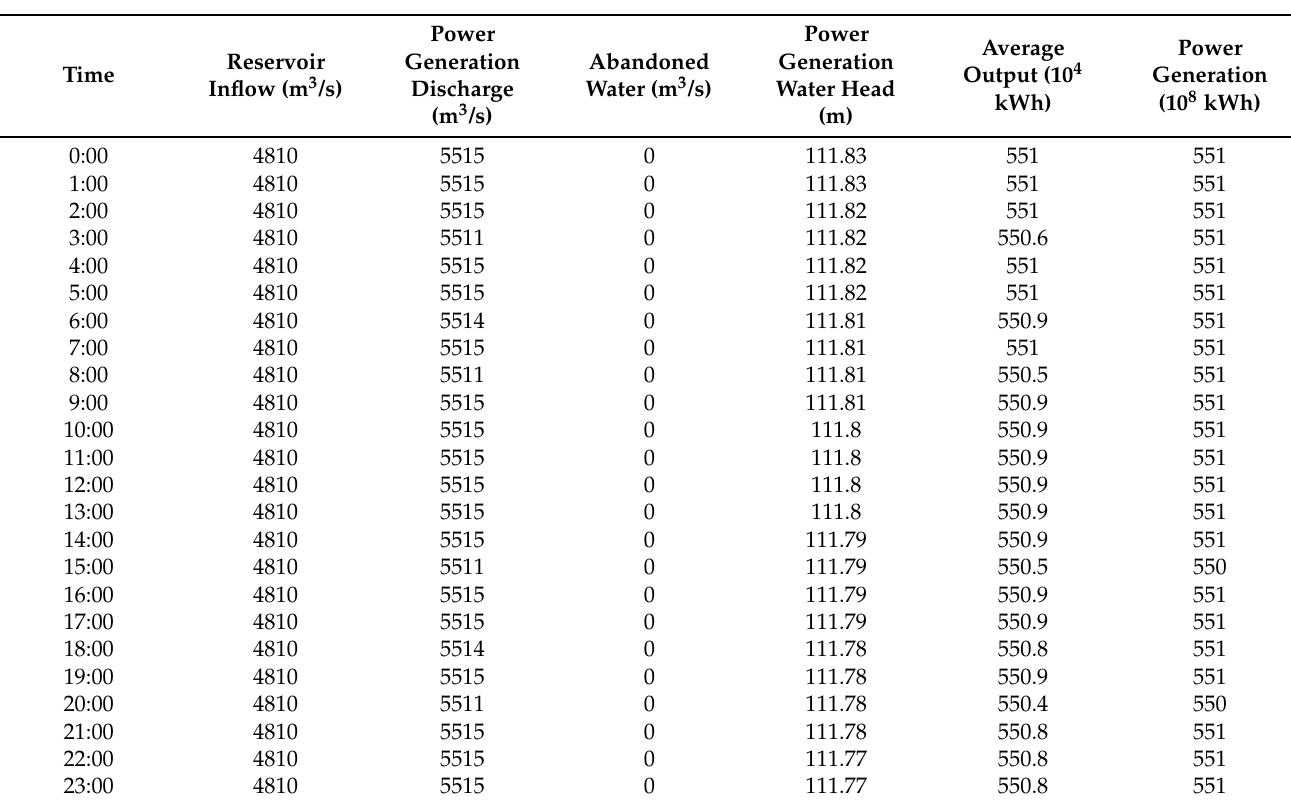
Table 10. Implementation effect statistics of 1 January operation plan for TG reservoir (hourly